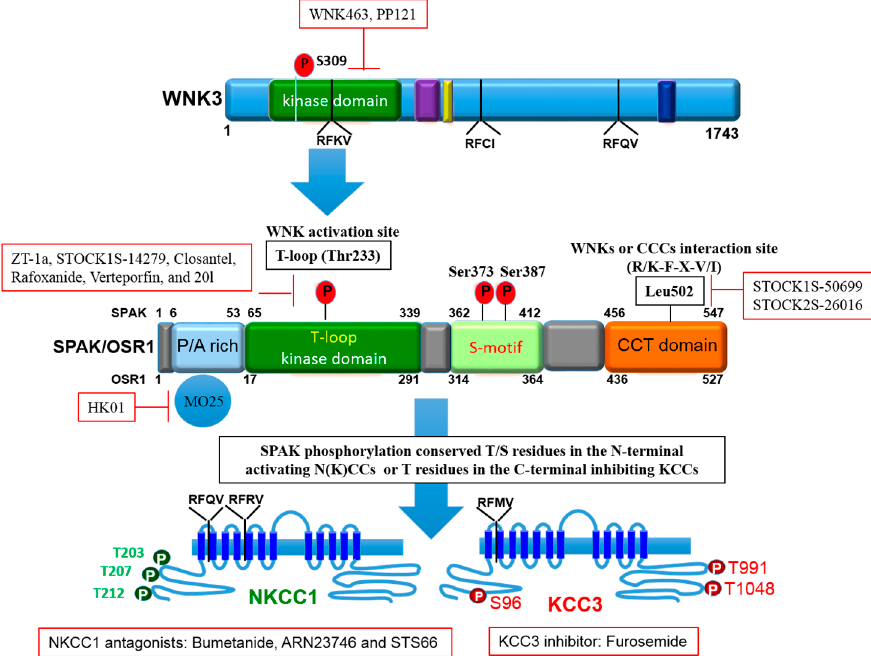
Figure 4. The domain structure of SPAK and the phosphorylation target sites on NKCC1 and KCC3. OSR1 lack the P/A rich (PAPA) domain that is present in SPAK. The figure depicts small molecule inhibitors that target the WNK-SPAK-CCC signaling pathway and their sites of actions. STOCK1S-50699 and STOCK2S-26016 operate through binding to the CCT domain consequently blocking the interaction between SPAK/OSR1 and WNK. STOCK1S-14279, Closantel, Rafoxanide, Verteporfin, and 20l bind the T233E residue on SPAK that is constitutively active or WNK-sensitive. WNK463 and PP121 that inhibit WNKs catalytic activity. HK01, an inhibitor of the mouse protein-25 (M025). Bumetanide, ARN23746 and STS66 are NKCC1 antagonists. Furosemide is a KCC3 inhibitor. ZT-1a is a specific SPAK inhibitor. CCCs, cation-chloride cotransporters; NKCC1, K + -Cl − cotransporters; KCC3, K + -Cl − cotransporter 3; WNK, with-no-lysine kinase; SPAK, STE20/SPS1- related proline/alanine rich kinase; OSR1, oxidative stress response